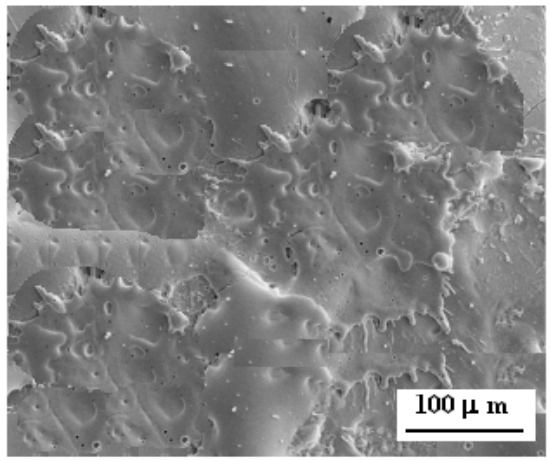
Figure 2. Photograph image of Al/Cu surface produced by the electrical discharge alloying method.